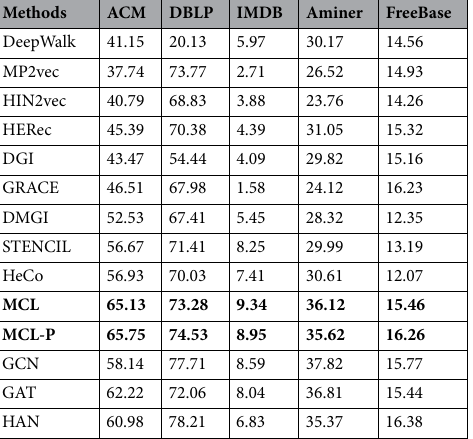
Table 3. Performance of node clustering on five benchmark datasets. Boldfaces denote the best performance among self-supervised and supervised methods, respectively. For our model, we use the suffix -P to indicate the positive sampling version.